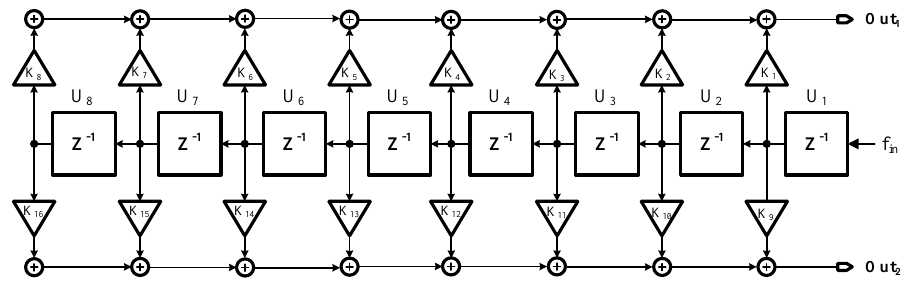
Figure 3. Structure of the capacitive multi-phase FIR filter with two phases output.